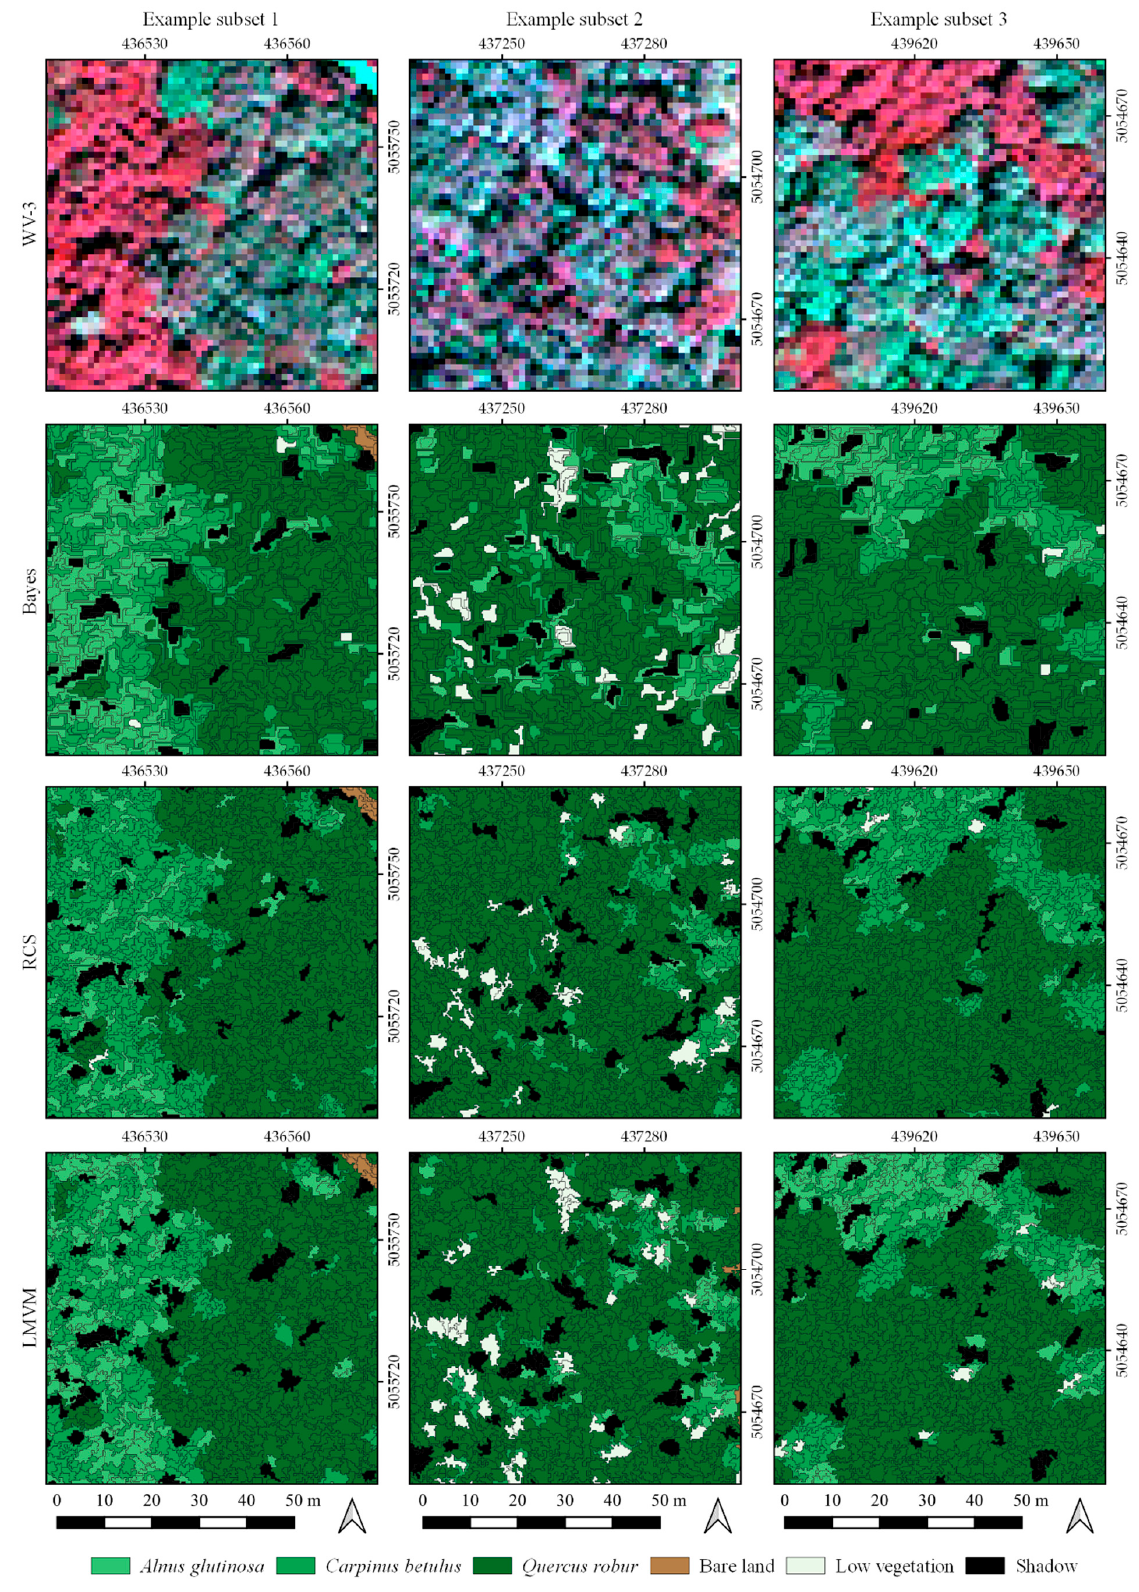
Figure 4. Three example subsets: ( 1st row ) false-color composite of WV-3; ( 2nd row ) object-based classification using Bayes pansharpened imagery; ( 3rd row ) object-based classification using RCS pansharpened imagery; ( 4th row ) object-based classification using LMVM pansharpened imagery.